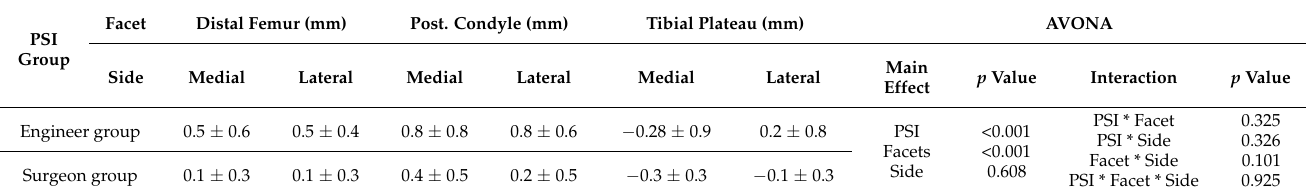
Table 2. Bone resection discrepancies (mean ± SD) between the preoperative PSI design and intraoperative actual measurements.